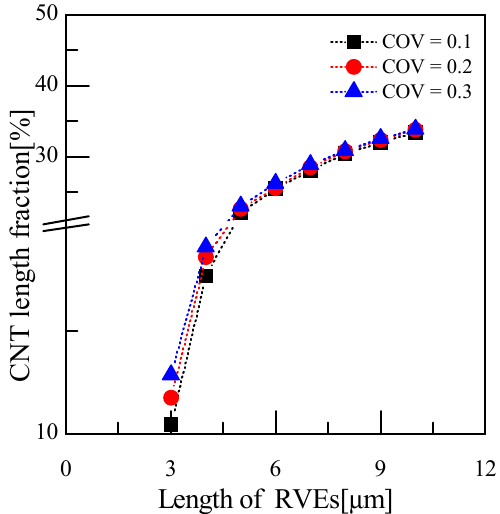
Figure 14. Length fraction of CNTs greater than 2 µ m according to changes in the COV. To analyze the changes in the effective properties according to increases in the RVE length, the rate of change was examined based on the effective properties of the 3 µ m RVE shown in Figure 8. First, the rate of change in the effective properties according to the RVE length is shown in Figure 15a. When the rate of change in the effective properties in a 3 µ m RVE was 100%, this rate gradually increased as the RVE length increased and reached 118–120% for a 10 µ m RVE. For a more detailed analysis, Figure 15b shows the rate of increase for an RVE that is 1 µ m less than the target RVE. From 3 to 4 µ m RVEs, this rate increased by approximately 5–6%, but as the RVE gradually increased beyond this point, this rate gradually decreased. From 9 to 10 µ m RVEs, the change was approximately 1%.